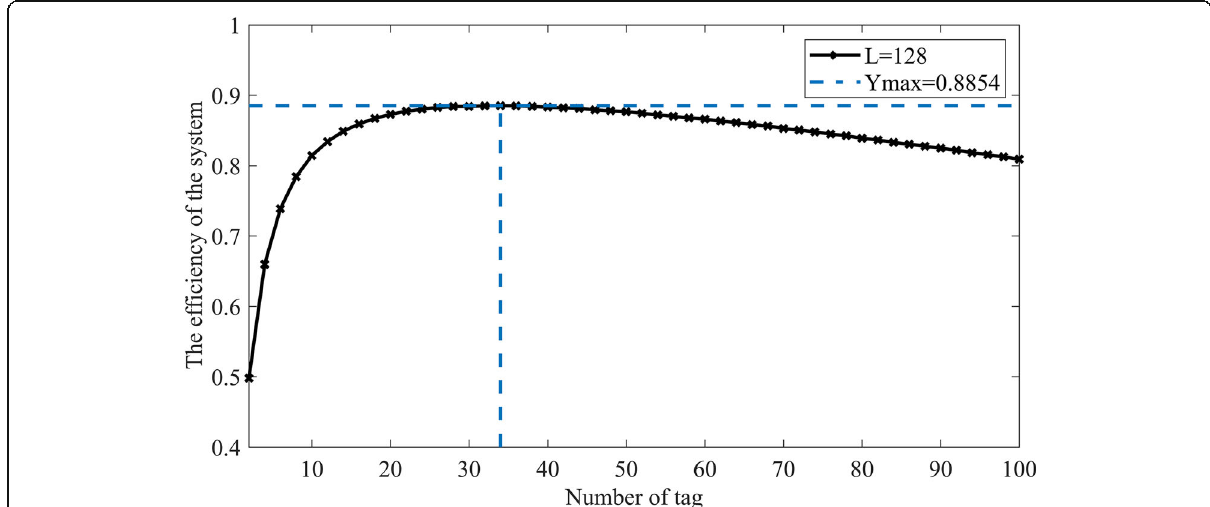
Fig. 10 Single identification of system efficiency versus the number of tags